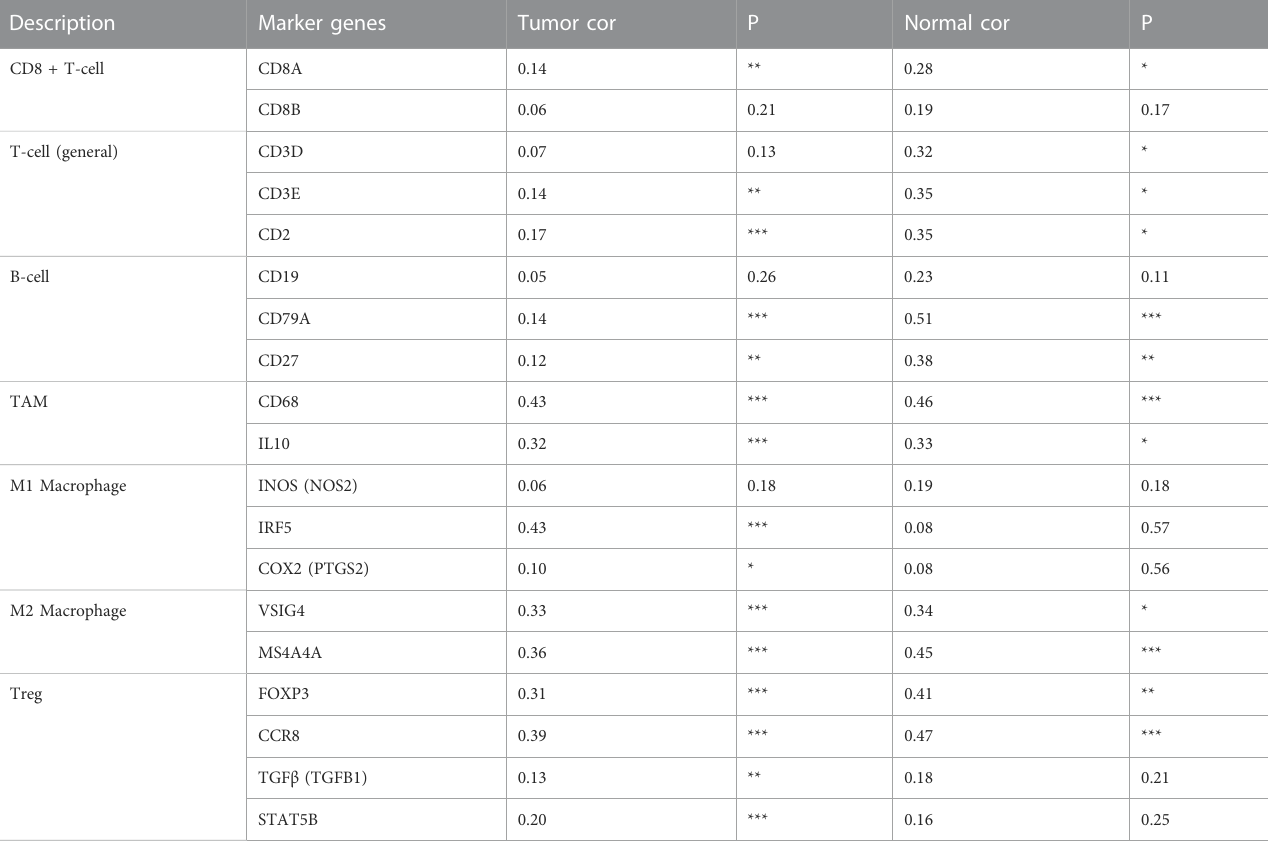
TABLE 4 Correlation analysis between KNL1 and gene markers of immune cells in GEPIA2.